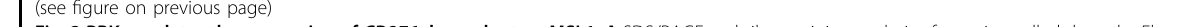
Fig. 3 PBK regulates the expression of CD276 dependent on MSL1. A SDS/PAGE and silver staining analysis of proteins pulled down by Flag-PBK or vector, via anti-Flag af fi nity puri fi cation. Mass spectrometry analysis recognized MSL1 (male-speci fi c lethal 1 homolog) as an interacting partner of PBK. B 293T cells were co-transfected Myc-MSL1 with vector, Flag-GFP (green fl uorescent protein), or Flag-PBK for 36 h, and immunoprecipitation assays and immunoblotting analyses with the indicated antibodies were performed. C Endogenous immunoprecipitation assay in CNE2 and SUNE1 cells with an anti-PBK antibody followed by immunoblotting with antibodies against the indicated proteins. D Immunoprecipitation assays and immunoblotting analyses with the indicated antibodies were performed in PBK-overexpression stable cell lines or control cell lines. E CNE2 and SUNE1 cells were transfected with PBK siRNAs or NC (nonspeci fi c siRNA) for 48 h. Immunoprecipitation assays and immunoblotting analyses with the indicated antibodies were performed. F CNE2 and SUNE1 cells were treated with DMSO or OTS514 (5 μ M) for 24 h. Immunoprecipitation assays and immunoblotting analyses with the indicated antibodies were performed. G CNE2 and SUNE1 cells were transfected with two MSL1 siRNAs or NC (nonspeci fi c siRNA) for 48 h. qPCR and Immunoblotting were conducted to measure the mRNA and protein expression of CD276 . Left, qPCR. Right, immunoblotting with indicated antibodies. H CNE1 and HK1 cells were infected by lentiviruses carrying MSL1 coding region to establish the MSL1 overexpression stable cell lines. qPCR and immunoblotting were conducted to measure the mRNA and protein expression of CD276 . Left, qPCR. Right, immunoblotting with indicated antibodies. I PBK-overexpression cell lines or control cell lines were transfected with one MSL1 siRNA or NC (nonspeci fi c siRNA) for 48 h, respectively. qPCR assays were conducted to measure the mRNA level of CD276 . Left, CNE1 cell lines, right, HK1 cell lines. J MSL1 wild type or serine/threonine residues' mutant overexpression cell lines or control cell lines were transfected with a PBK siRNA or NC (nonspeci fi c siRNA) for 48 h. qPCR assays were conducted to measure the mRNA level of CD276 . Left, CNE2 cell lines, right, SUNE1 cell lines. J In qPCR assays, ACTB was used as the loading control, and the mRNA level of CD276 is normalized to ACTB . The results are shown as the fold change over NC (nonspeci fi c siRNA). Data present as the mean ± SEM ( n = 3). ** P < 0.01, *** P < 0.001, ns not signi fi cant (Student ’ s t test for two groups, one-way ANOVA for three groups). All the experiments were performed independently three times with similar results and the data are representative of three independent